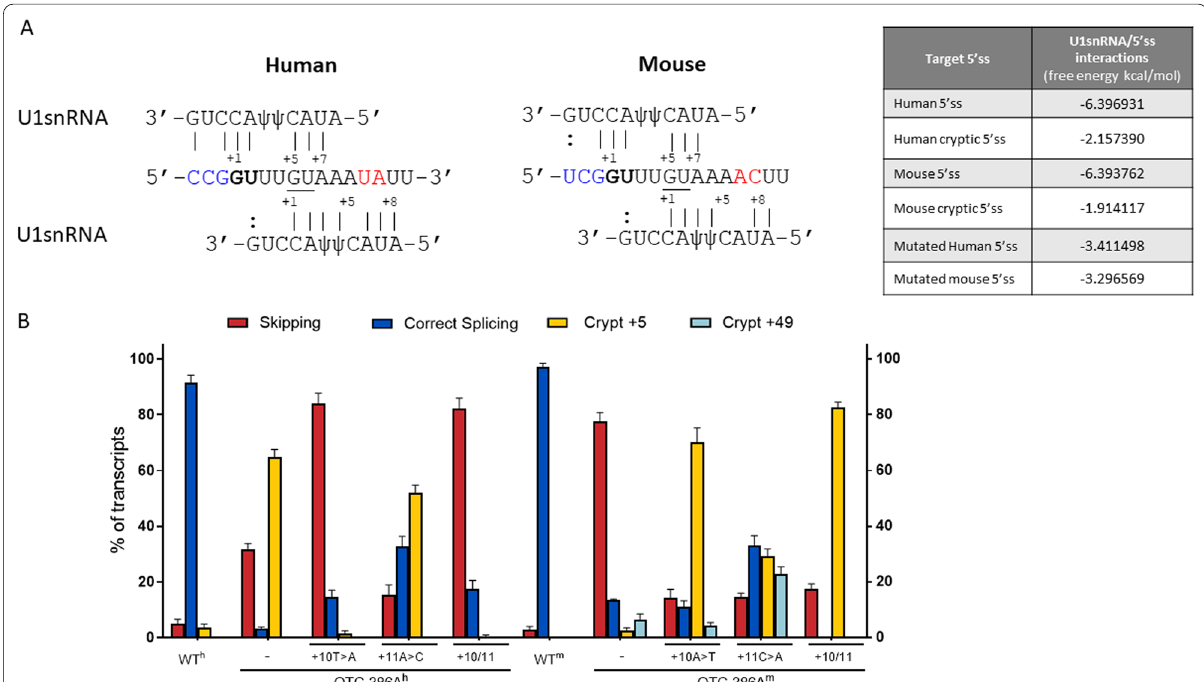
Fig. 2 Nucleotide variations at 10-11 positions dictate species-specific splicing patterns. A Base pairing between the 5 ′ tail of the U1snRNA and + the authentic (bold) or cryptic (underlined) 5 ′ ss of human and mouse OTC pre-mRNA. Intronic nucleotides at position 10-11 are show in red. + Continuous lines represent perfect matches while dashed line indicates partial complementarity. Nucleotides of OTC exon 4 are highlighted in blue. The minimum free energy (MFE) scores of interactions between the 5 ′ tail of U1snRNA and the targeted 5 ′ ss are reported in the table on the right. B Splicing patterns of OTC h and OTC m minigenes, either wild-type (wt) or mutated, in HepG2 and Hepa1-6, respectively. Bar plots report the relative percentage of each transcript, expressed as mean standard deviation (SD) from three independent experiments. The transcript type is indicated ± on the